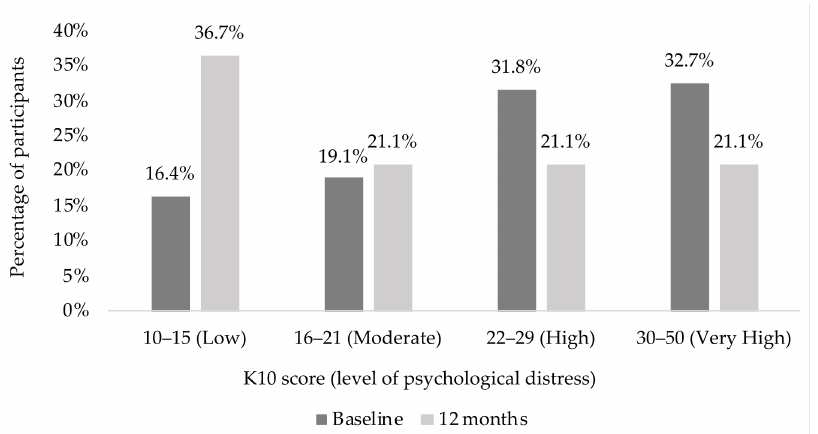
Figure 3. Kessler Psychological Distress Scale (K10) scores and level of psychological distress at baseline and 12 months.